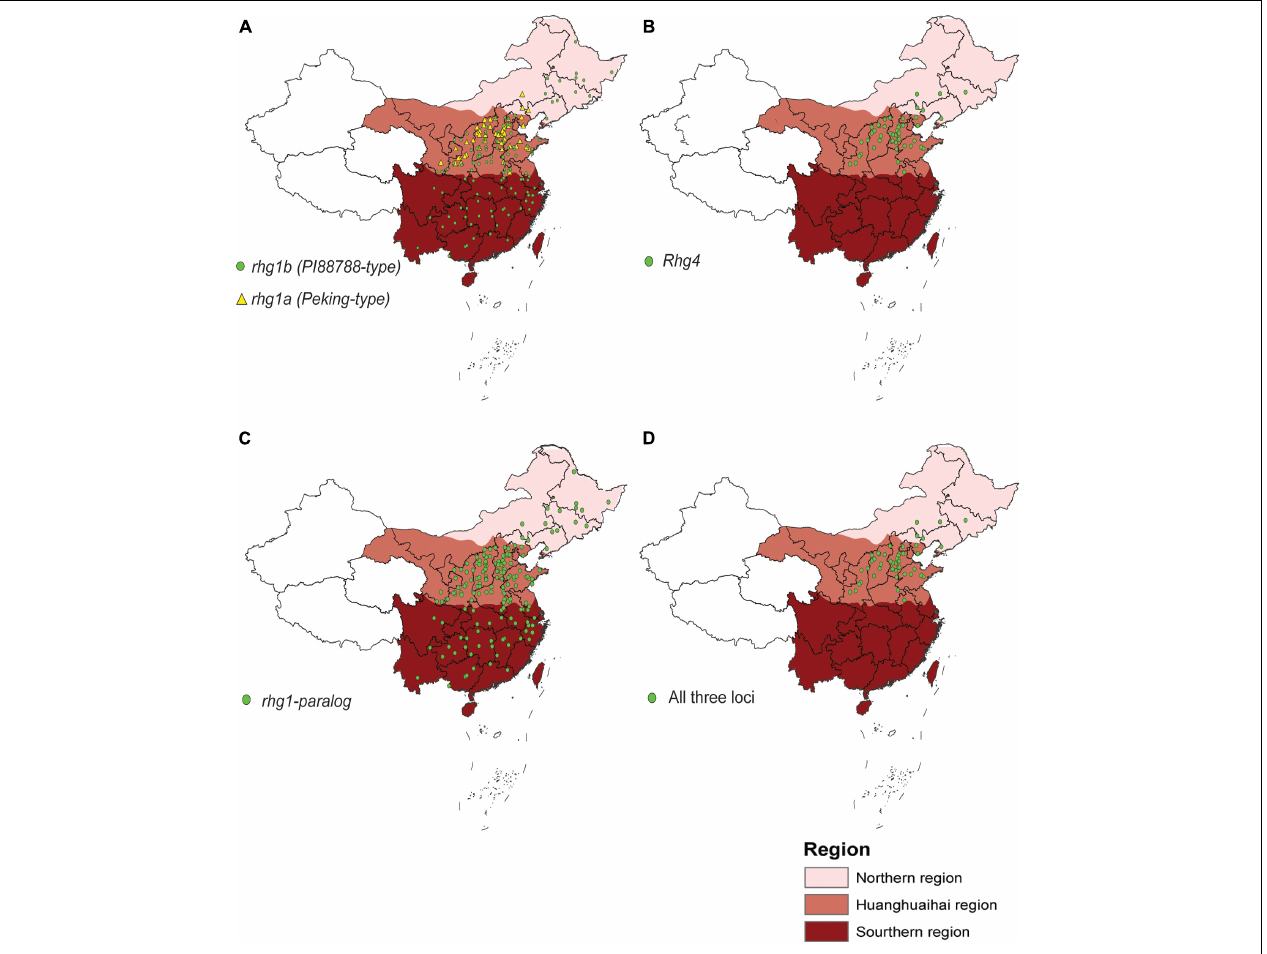
FIGURE 4 | Map showing the distribution of resistance loci in 1025 Chinese accessions across Northern, Huanghuaihai and Southern regions of China. (A) rhg1a and rhg1b ; (B) Rhg4 ; (C) rhg1-paralog ; and (D) all three Rhg